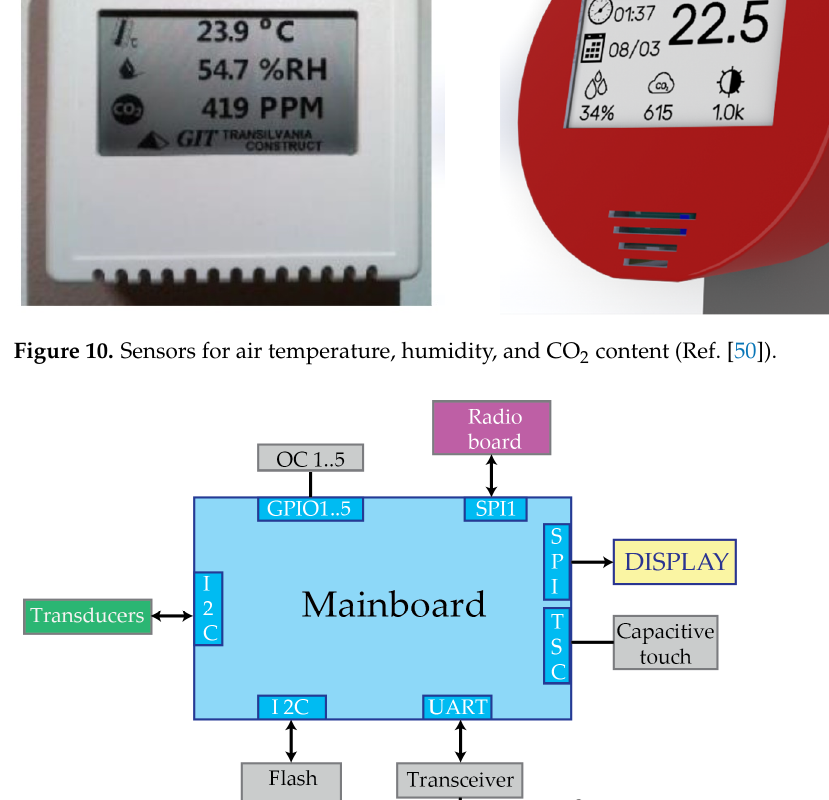
Figure 13. Interfacing board prototype. While, from the hardware point of view, this approach accelerated the development of the prototype smart meter, from the software point of view, the reusability of the ex- isting module (tailored for the protocol, procedures, and usage scenarios of the Physis platform), guarantees an easy integration with existing residential comfort infrastruc- tures. This creates the framework for achieving the alignment of the smart metering so- lution with the existing BMS and smart-home systems, toward the integrated smart- home architecture indicated in Figure 9. The STMicroelectronics STPM32 energy metering evaluation board [54] was used to monitor the active/reactive power of the appliances. The characteristics of the board in- clude: 0.2%-accuracy single-phase meter, V nom (RMS) = 140–300 V, I nom /I max (RMS) = 5/100